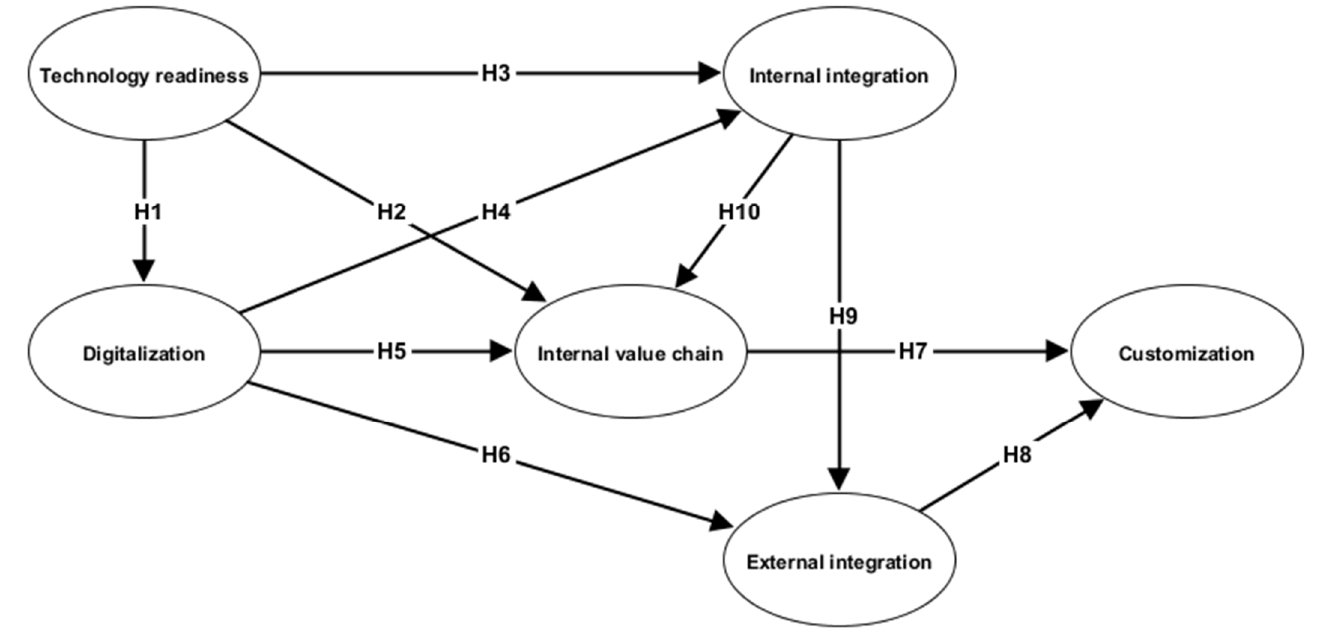
Figure 1. The conceptual research process model of the Industry 4.0 framework.